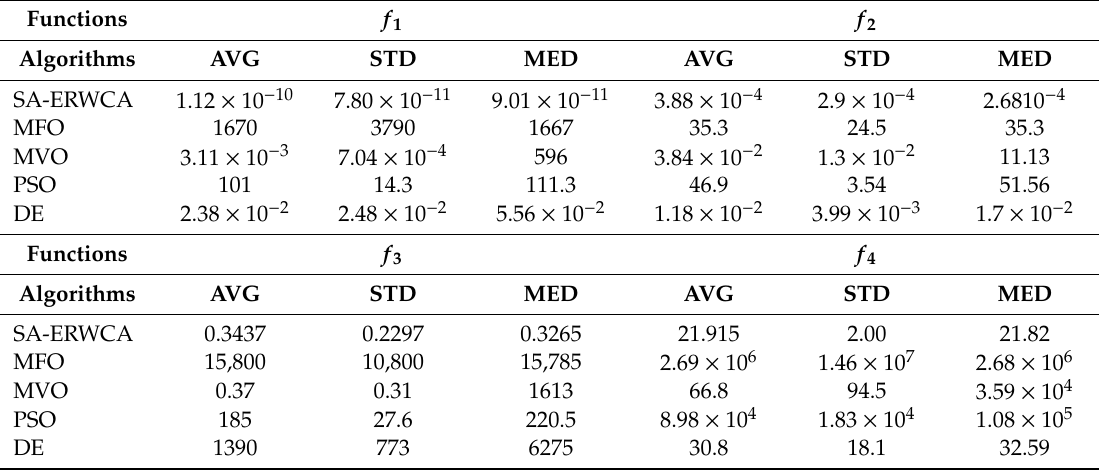
Table 7. Comparison results of the 4 functions during 300,000